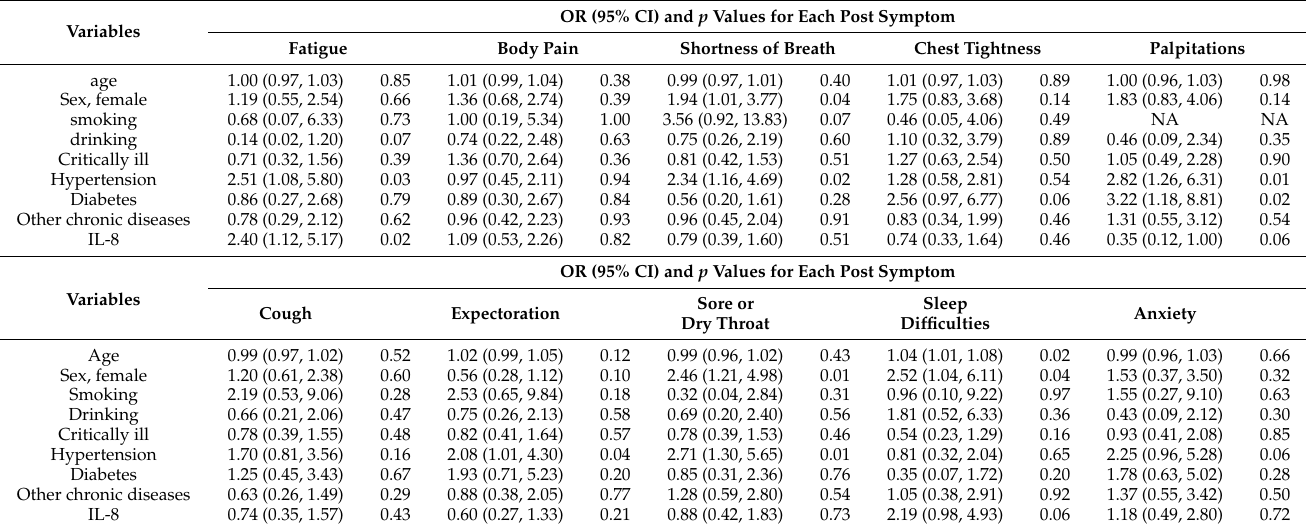
Table 4. Risk factors associated with the top ten symptoms one year after discharge.